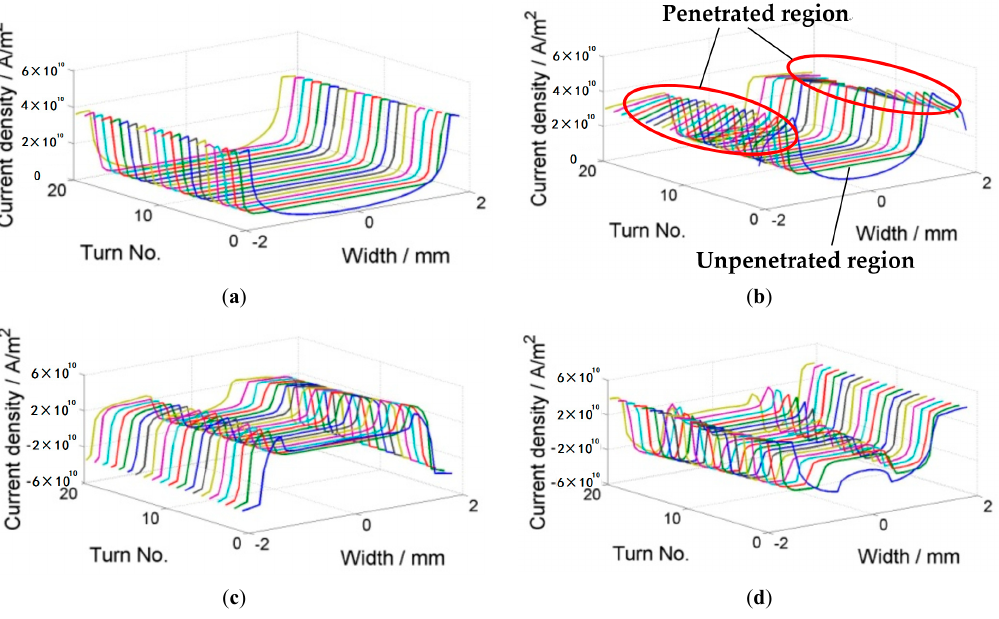
Figure 6. Current distribution for 20 turns with an external field of − 0.2 T: ( a ) ramping up to 30 A; ( b ) ramping up to 80 A; ( c ) ramping down to − 30 A; ( d ) ramping up to 0 A. Tape No. 1 is in the innermost turn .